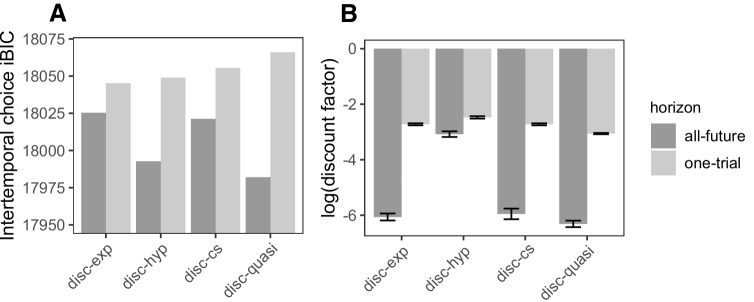
Comparison of all-future horizon and one-trial horizon discounting models.(A) iBIC for the full horizon and one-trial horizon discounting models (B) Measured log-transformed discount factors for the full horizon and one-trial horizon discounting models. Bars and errorbars represent mean ± standard error.